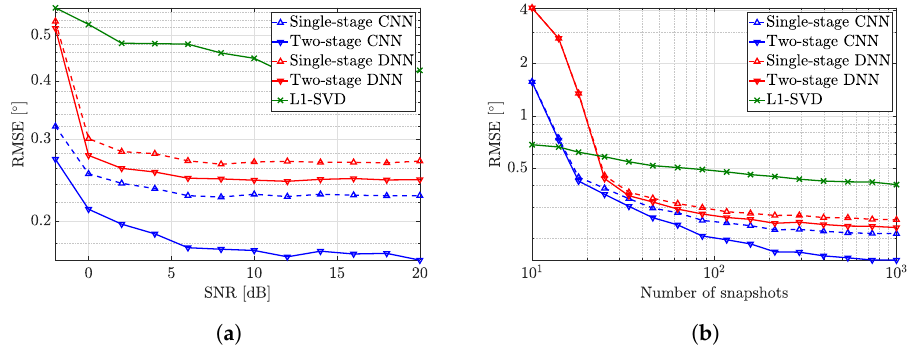
Figure 5. ( a ) The RMSE for different SNR. Q = 1000 and D = 256. ( b ) The RMSE for different number of snapshots. Q = 1000 and the SNR is set to 10 dB.